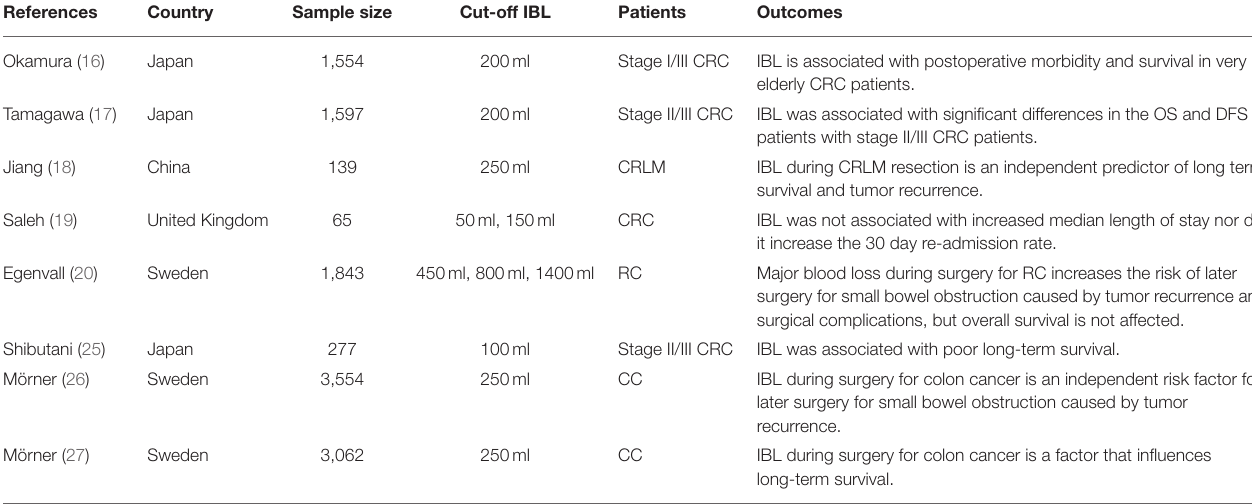
TABLE 9 | Previous studies reporting the IBL on the outcomes of CRC